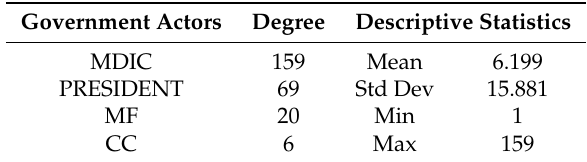
Table 2. Government actors Freeman degree